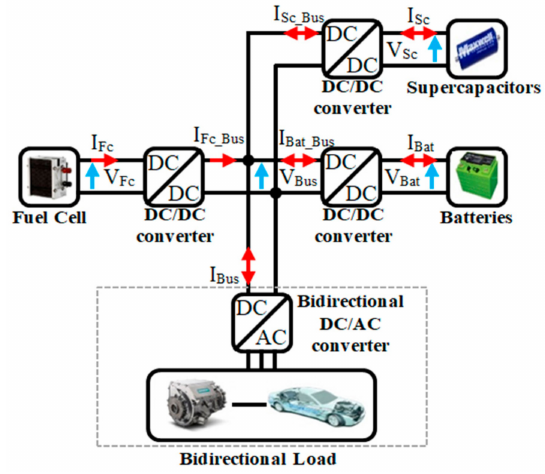
Figure 1. Electric vehicle (EV) system